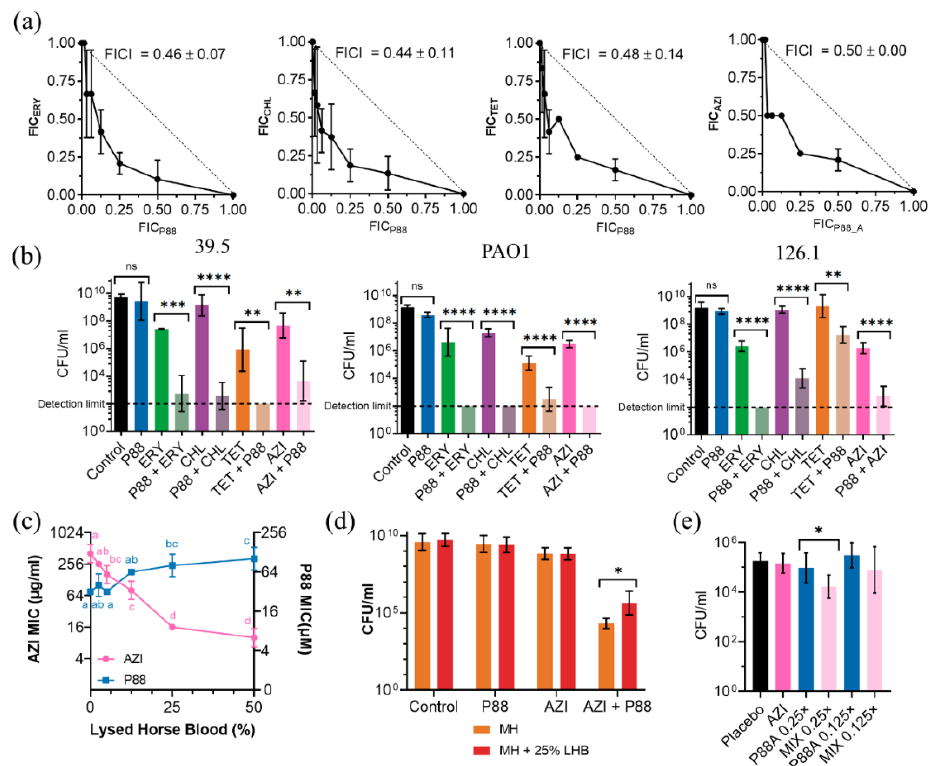
Figure 7. Synergy of peptide P88 with several antibiotics. ( a ) Checkerboard assay isobolograms of different P88-antibiotic combinations against P. aeruginosa 39.5 (ERY, CHL, TET, AZI). Mean ± sd of the minimum FICI values are displayed. ( b ) Viable counts of P. aeruginosa strains 39.5, PAO1, or 126.1 treated overnight ( ≈ 16–20 h) at 37 ◦ C in Mueller-Hinton (MH) medium (initial inocula ≈ 10 5 CFU/mL) with 0.25 × MIC of an antibiotic, P88 or a combination of 0.25 × MIC of each, plus the untreated control. One-way ANOVA followed by Tukey post-test was used to determine pairwise significant differences as indicated by the figure (** p ≤ 0.01; *** p ≤ 0.001; **** p ≤ 0.0001; ns = nonsignificant). ( c ) AZI or P88 MIC for P. aeruginosa 39.5 determined in MH broth supplemented with different concentrations of lysed horse blood. A two-way ANOVA followed by a Tukey post-test was applied to find statistically significant differences between concentrations within each experimental condition (i.e., comparing the result for the different concentrations of each antimicrobial). Different letters indicate significantly different results. ( d ) Viable counts of P. aerug- inosa 39.5 treated overnight ( ≈ 16–20 h) at 37 ◦ C in MH medium (initial inocula ≈ 10 5 CFU/mL) with 0.25 × MIC of an antibiotic, P88 or a combination of 0.25 × MIC of each, plus the untreated control, with or without 25% lysed horse blood. Significant differences according to t -test are in- dicated (* p ≤ 0.05). ( e ) Bacterial counts of P. aeruginosa 39.5 recovered from the lungs of infected mice and treated with AZI (100 mg/kg), P88 (12.5 µ M or 6.25 µ M, respectively 0.25 × or 0.125 × MIC, administered intranasally in 50 µ L) or a combination of both. * p ≤ 0.05 according to t -test. Four to eight independent samples are included per